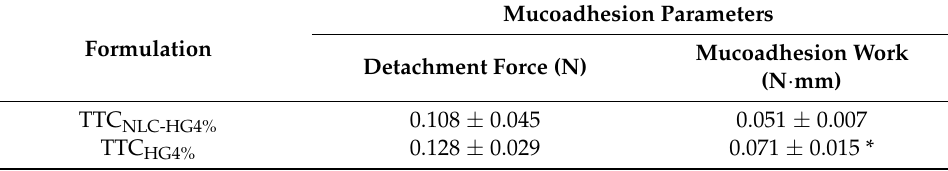
Table 3. Mucoadhesion parameters of the